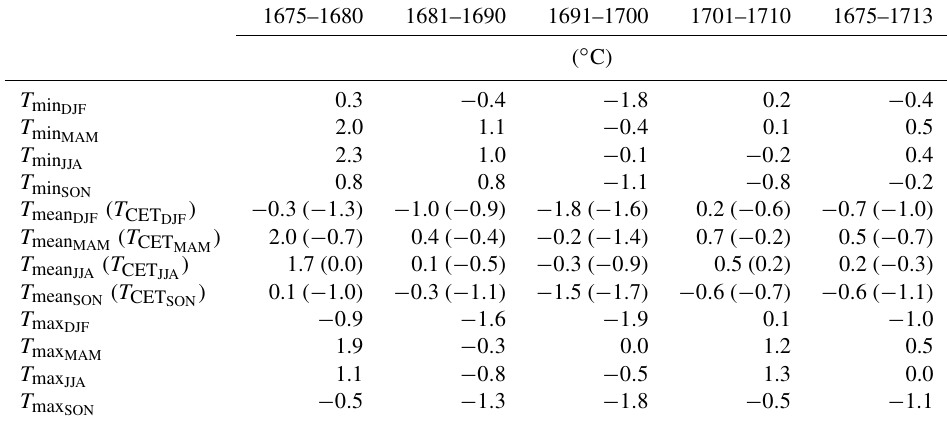
Table 2. Anomalies of T min , T max , and T mean divided into seasons (DJF, MAM, JJA, and SON) with respect to the reference period (E-OBS: 1961–1990). The CET is given as a comparison in the brackets of the mean temperatures.